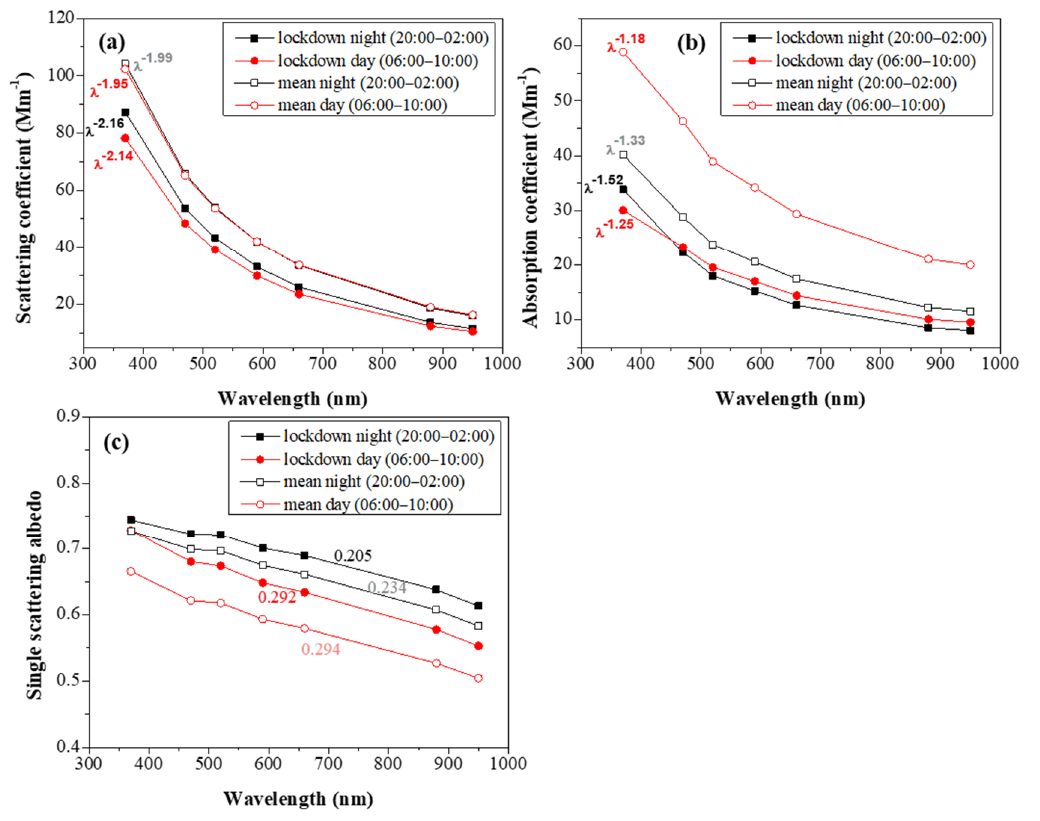
Figure 8. Spectral-scattering ( a ), absorption ( b ) and SSA ( c ) at night and day hours during 20 March–3 May, in 2017–2019 (2016–2019 for absorption) and in the same period in 2020 (lockdown). The averaged coefficients for the spectral-scattering, absorption as well as the Ångström exponents for the SSA are given in each panel.